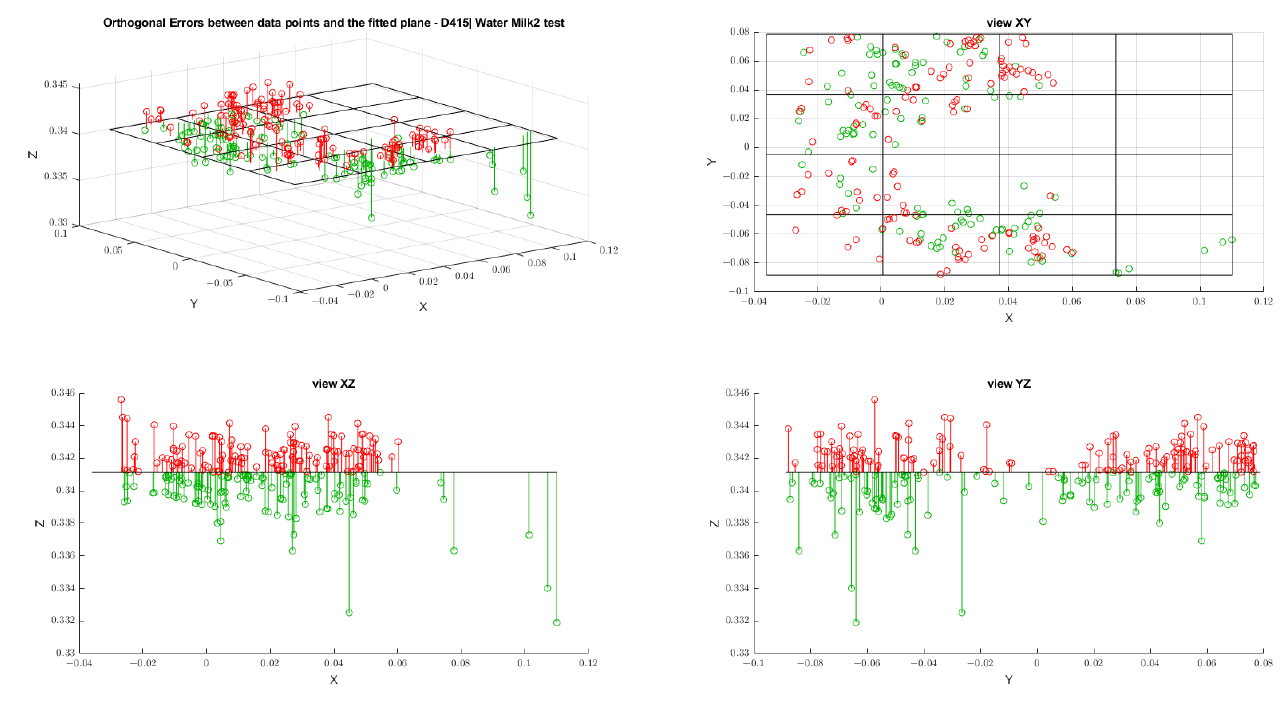
Figure A5. Results of orthogonal errors for the D415 camera referring to the water milk2 test.